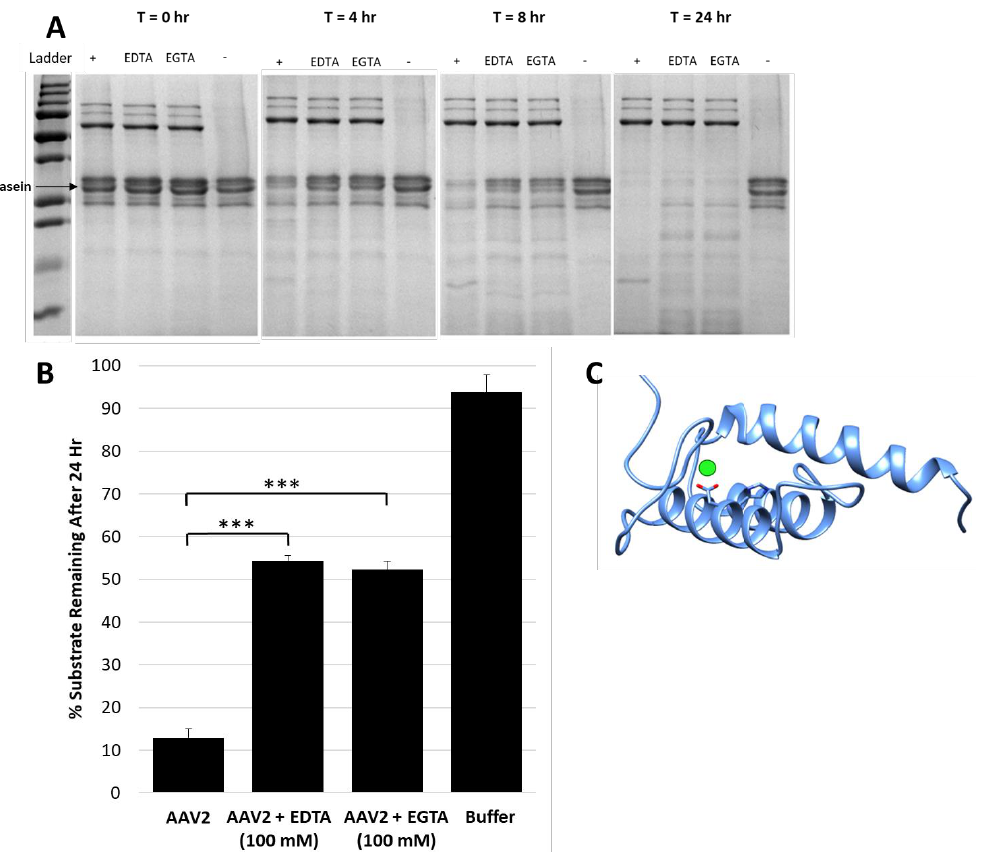
Figure 2. Metal chelators EDTA and EGTA reduce protease activity. ( A ) SDS-PAGE showing casein proteolysis by AAV2 in presence of 4 mM EDTA or EGTA. “ + ” indicates control with no inhibitor and “-” indicates control with no AAV2, that is, casein alone. The lane with AAV2 only (“ + ”) shows fastest decrease in casein with time. ( B ) Quantification of casein proteolysis by AAV2 in presence of either 100 mM EDTA or 100 mM EGTA. The y -axis indicates the amount of remaining protein after 24 h. ( C ) Predicted RaptorX structure model of AAV2 VP1u. PLA 2 catalytic residues H75 and D76 are in orange colored sticks, the predicted site of bound calcium is denoted by a green sphere next to D76. A predicted disordered portion of AAV2 VP1u N-terminal residues is not shown. Statistical significance as indicated by asterisk annotations (*) are described in Material and Methods